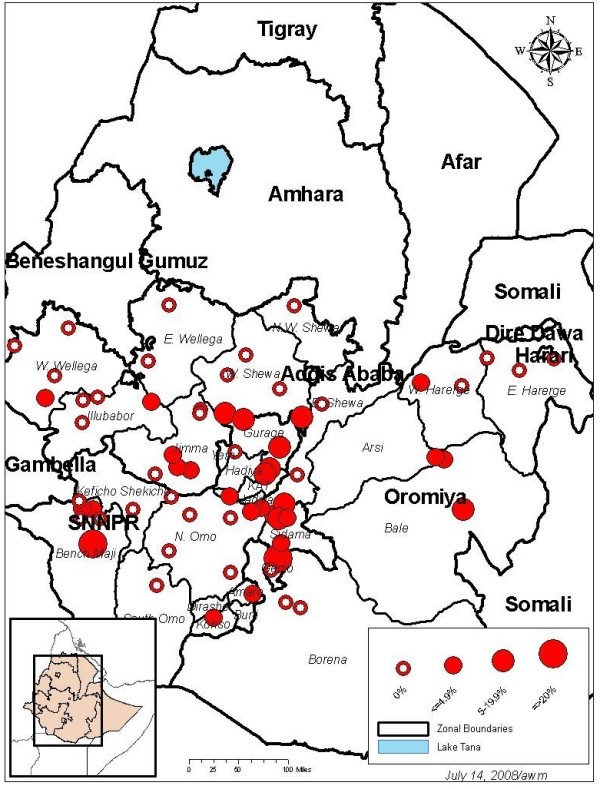
Map of Oromia and SNNPR Regions showing malaria parasite prevalence in January 2007.